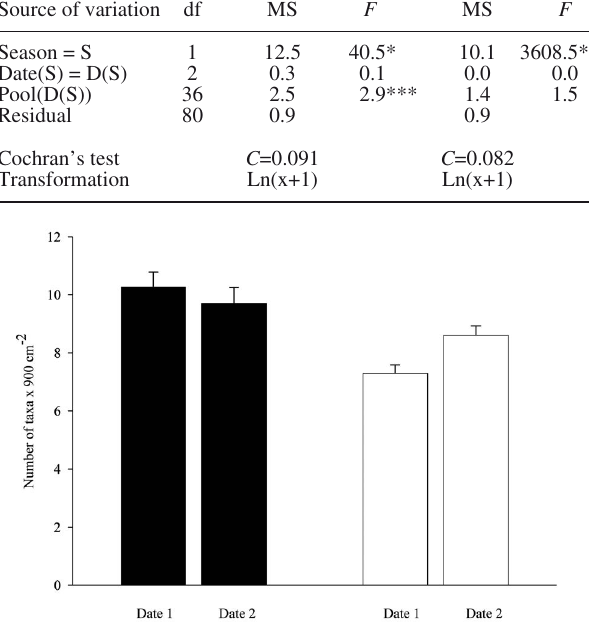
Fig . 3. – Mean (+SE) number of taxa sampled at each of two winter (black) and summer (white) dates. Data averaged over three repli- cate quadrates and ten